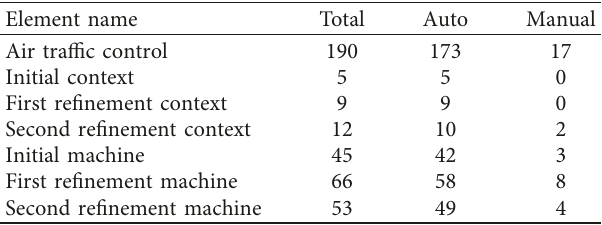
Table 1: Rodin report (Table 1 is reproduced from Jarrar and Balouki, (under the Creative Commons Attribution License))